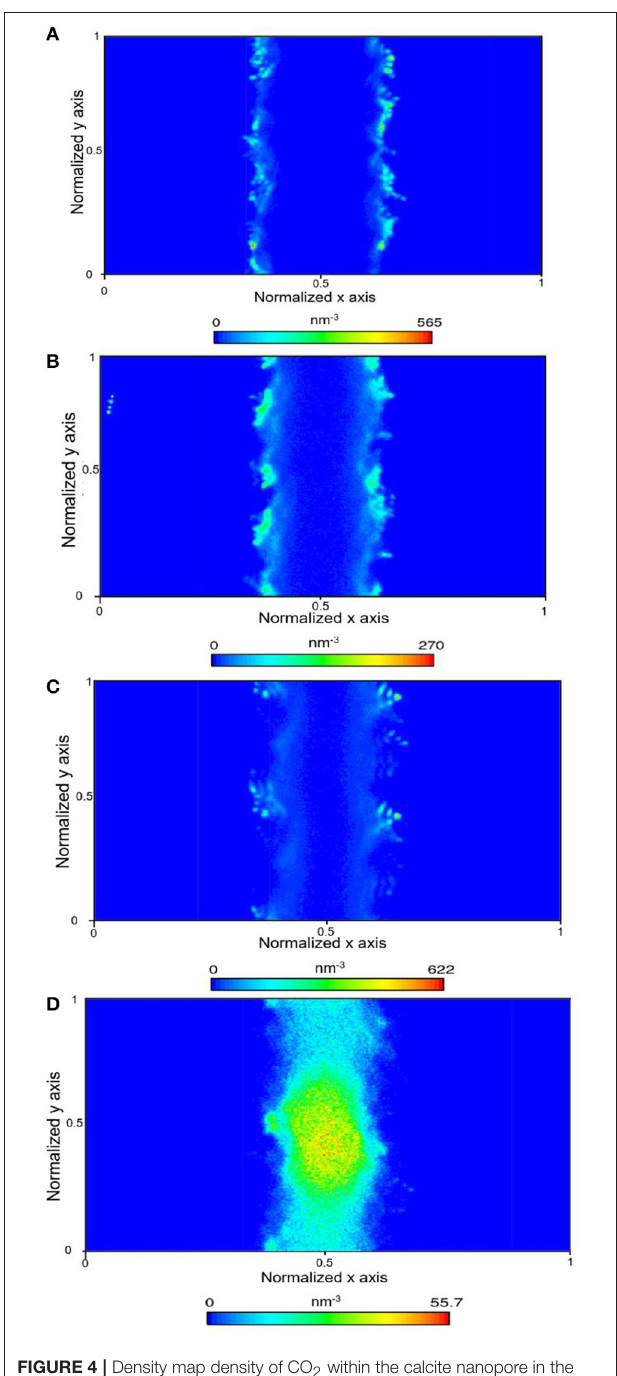
FIGURE 4 | Density map density of CO 2 within the calcite nanopore in the absence of pore water (A) , one layer of confined water composed of 150 water molecules (B) , 500 water molecules (C) , and 1296 water molecules that correspond to a density of bulk water of 1 g/cm 3 (D) .